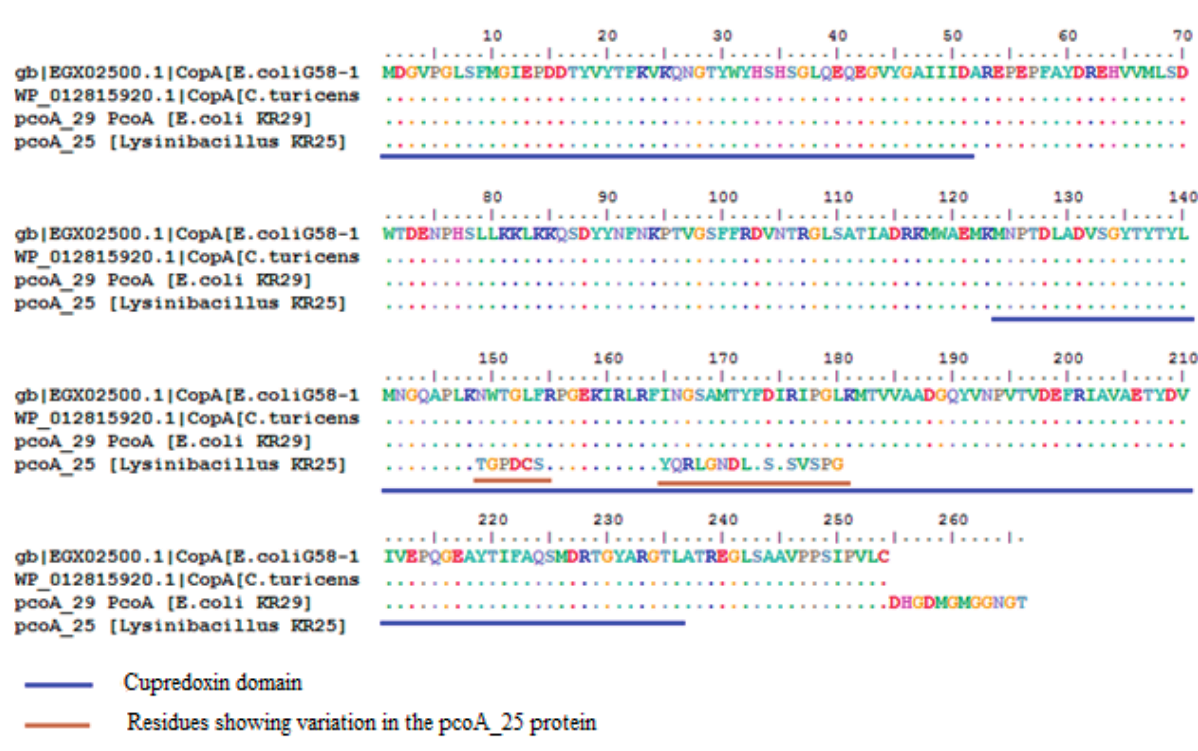
Figure 4. Alignment of the CopA protein from E. coli G58-1 (EGX02500.1) with the predicted partial PcoA proteins from Lysinibacillus KR25 and E. coli